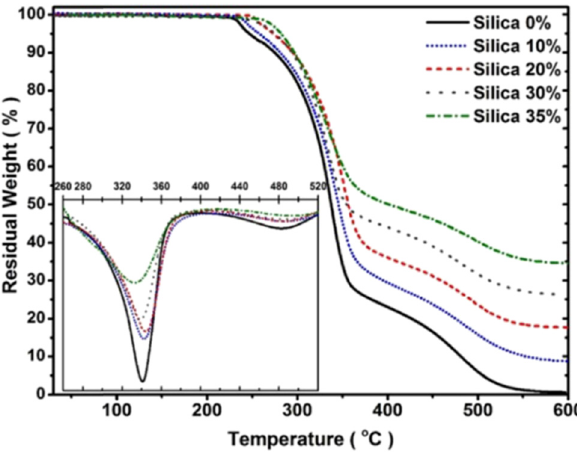
Figure 15: TGA diagram of latex fi lm with di ff erent components [ 102 ] ; Copyright: 2017 with permission from Springer.